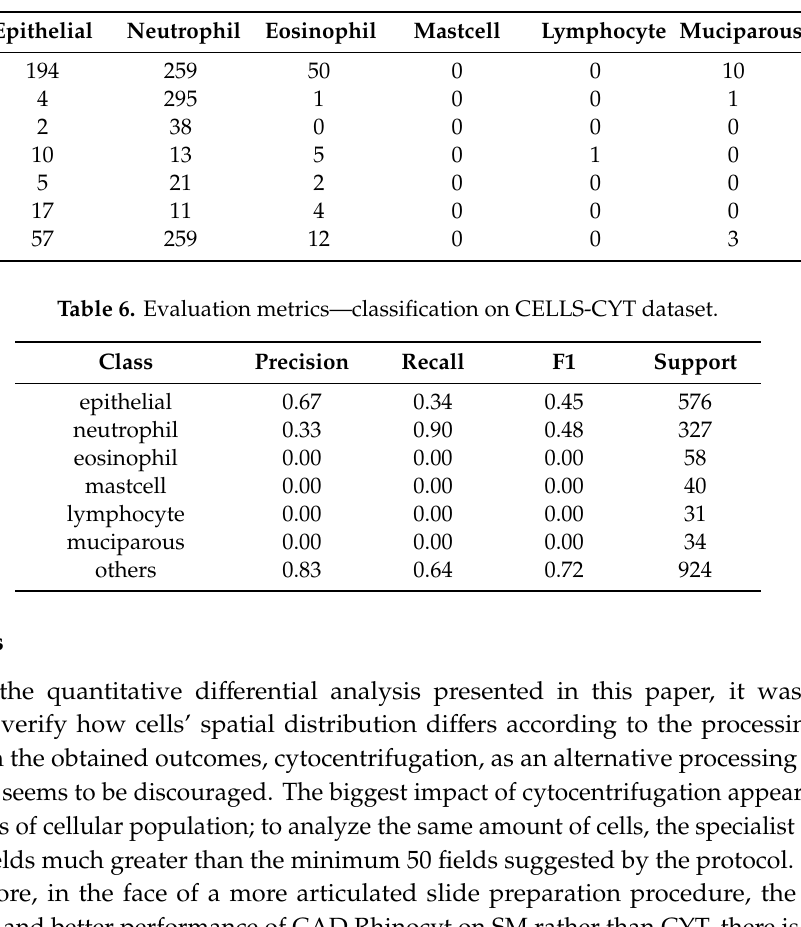
Table 5. Confusion matrix—Classification on CELLS-CYT dataset.